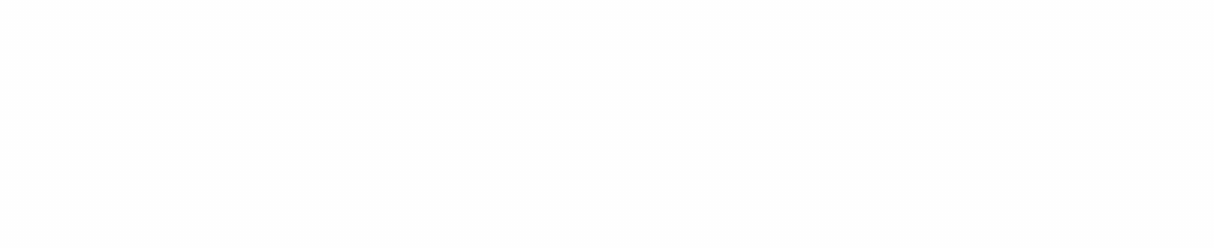
13___4% (n 4) which corresponds to 20.8% of adher- ent cells. The reason for a lower proportion of trans- migrated-over-adherent cells in the reverse assay resides probably in the fact that the double filter is a thicker barrier to